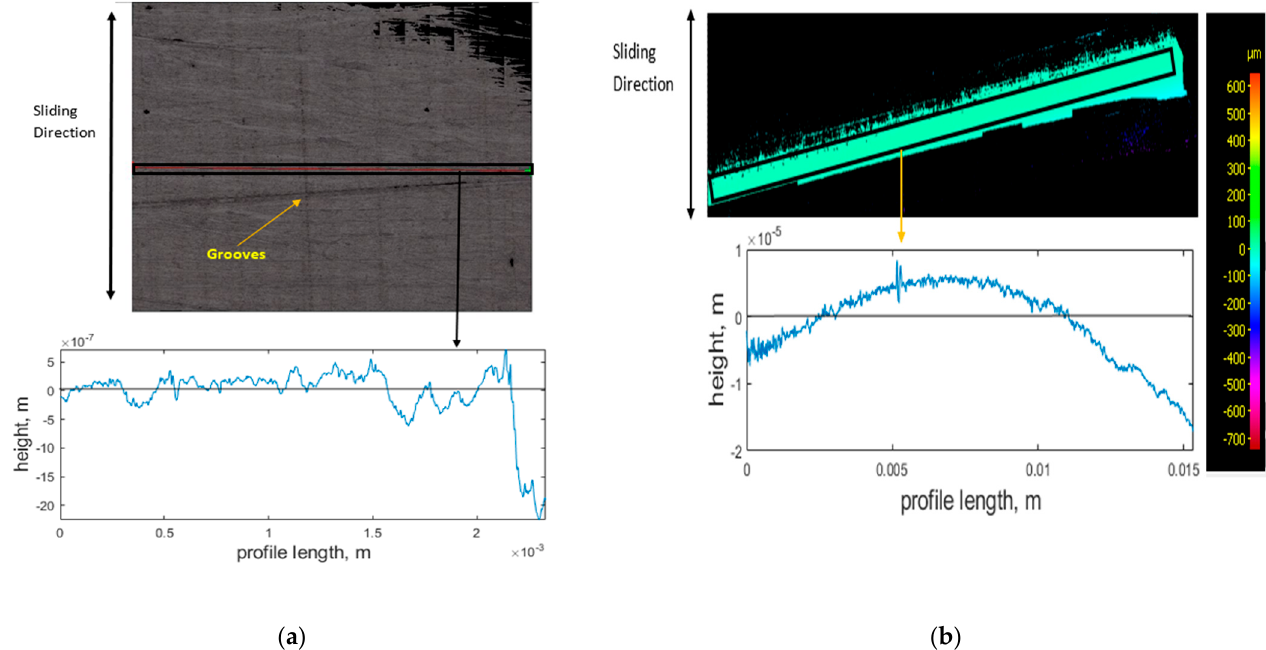
Figure 6. Abrasive test specimens, contour image, and corresponding graphical profiles of the worn regions after testing for ( a ) steel plate and ( b ) PEEK rods. Low topographical height shows material has broken away, indicating abrasive wear mechanism.